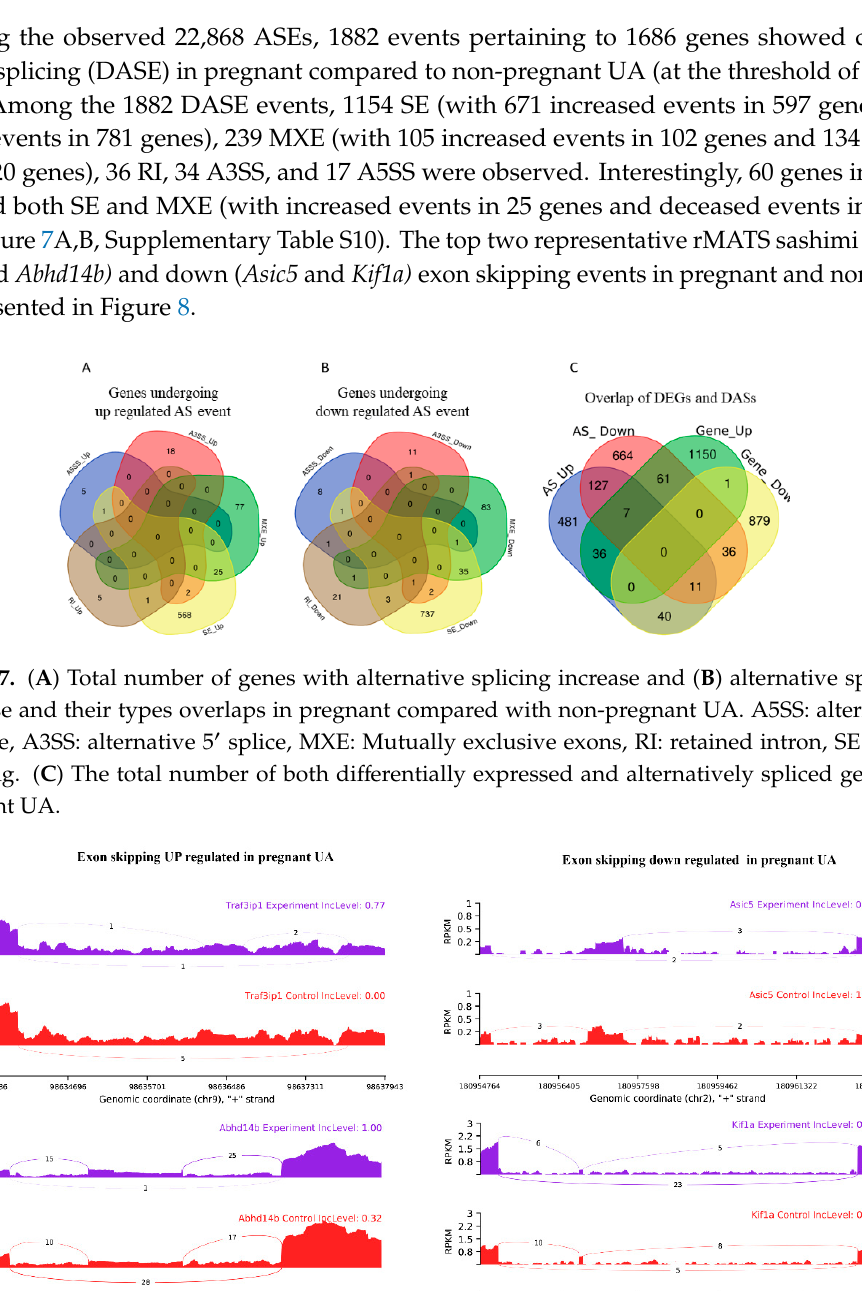
Figure 8. rMATS sashimi plot showing the up / down regulated exon skipping in pregnant UA. The higher rate skipped exon events at the transcripts of Traf3ip1 and Abhd14b and a lower rate of skipped exon events at the transcripts of Asic5 and Kif1a are presented. The tracks represent pregnant (blue) and non-pregnant (red) samples. The number on curved lines indicates continuous (top number) and di ff erentially-spliced (bottom number) exon-exon junction read counts. The x-axis depicts genomic coordinates. Inc level represents the exon inclusion level in pregnant and non-pregnant